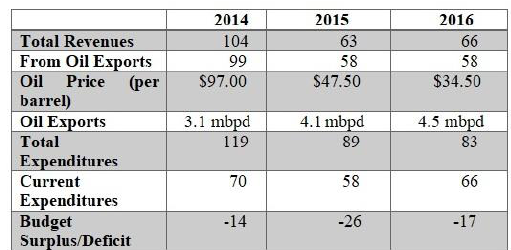
Table 1: Budget and Oil Production Statistics of Iraq for the 2014-2016 Period